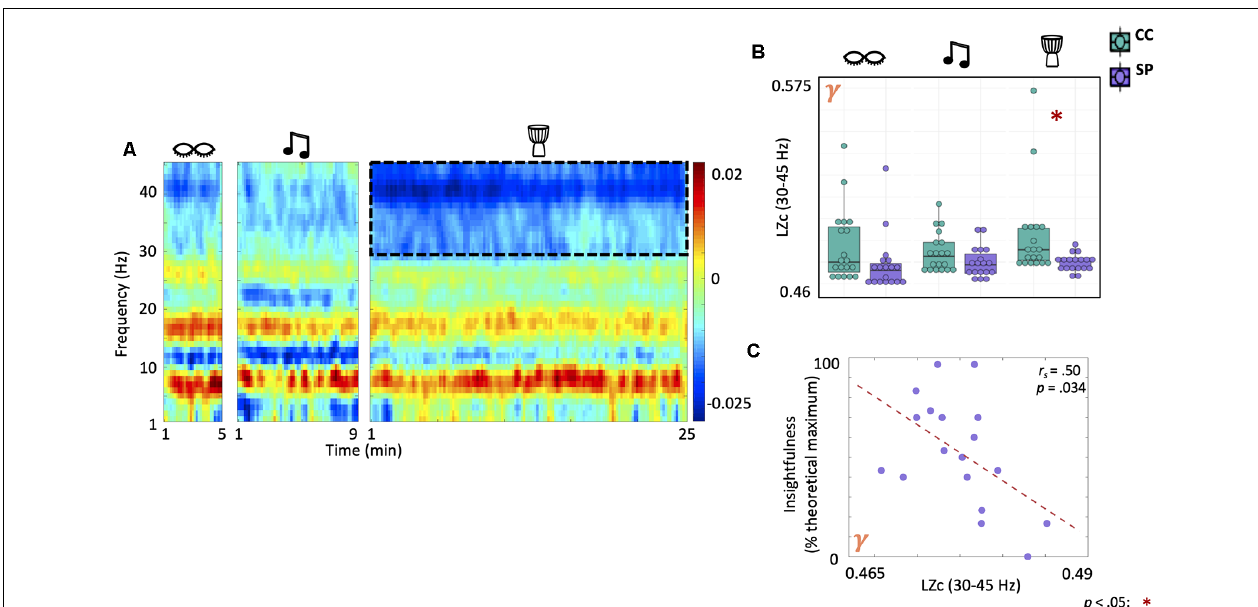
FIGURE 5 | Shamanic practitioners have decreased neural signal diversity in the gamma band during drumming which is negatively correlated with feelings of insightfulness. (A) Comparison of the Lempel-Ziv complexity (LZc), a surrogate measure of neural signal diversity, across frequencies in shamanic practitioners (SP; n = 18) and controls (CC; n = 19). Warmer colors represent greater LZc in SP while cooler colors indicate greater LZc in CC. The dotted lines represent the gamma band (30–45 Hz), which was significantly different between groups. (B) Box plots comparing the average LZc in the gamma band for SP (purple) and CC (green) during eyes closed, classical music, and drumming. Whiskers represent the lower (25%) and upper (75%) quartiles and the center band of each box represents the median for the group. SP experienced statistically significant decreases in LZc in the gamma band compared to CC. Significance is indicated by the key in the lower righthand corner of the figure. (C) Correlations between LZc in the gamma band and ASC domain scores revealed a negative correlation between gamma LZc and feelings of